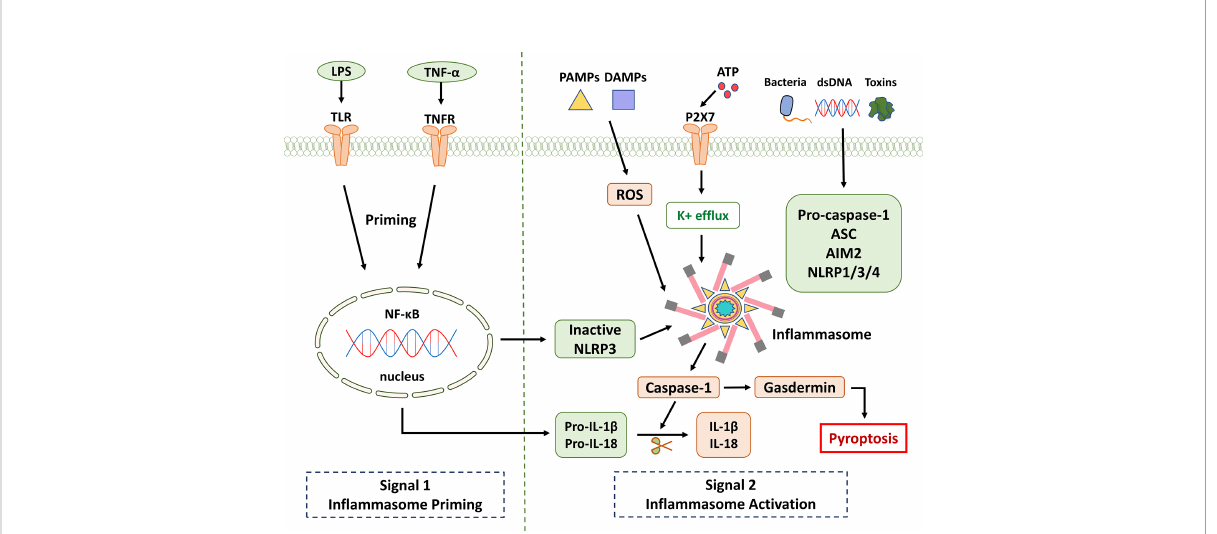
FIGURE 1 NLRP3 in fl ammasome signaling pathway. It is known that the activation of NLRP3 is divided into two key steps: priming and activation. Signal 1 (priming; left): When pathogens and their products, injury, stress, and other signals stimulate cells, TLR, TNFR, and other receptors can be activated. NF- k B is activated through different pathways, which in turn promotes NLRP3, pro-IL-1 b , and pro-IL-18. Provide a material basis for the activation and function of NLRP3 in fl ammasome. Signal 2 (activation; right): Multiple upstream signaling events are activated by PAMPs and DAMPs. These include K + ef fl ux, reactive oxygen species (ROS) production, etc. In fl ammasome formation activates caspase-1, which cleaves pro-IL-1 b and pro-IL-18. Gasdermin is also cleaved and inserted into membranes, forming pores and inducing